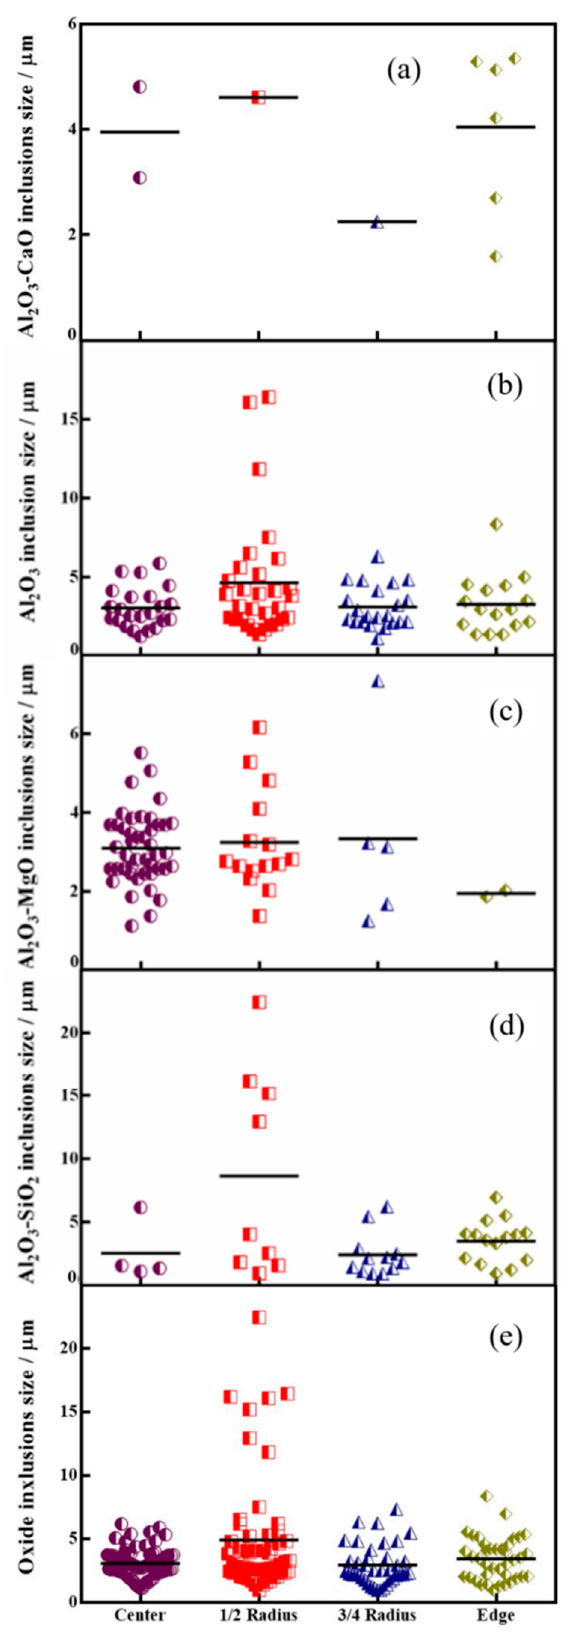
Figure 4. Size distribution of ( a ) Al 2 O 3 -CaO, ( b ) Al 2 O 3 , ( c ) Al 2 O 3 -MgO, ( d ) Al 2 O 3 - SiO 2 , and ( e ) all oxide inclusions at different locations.